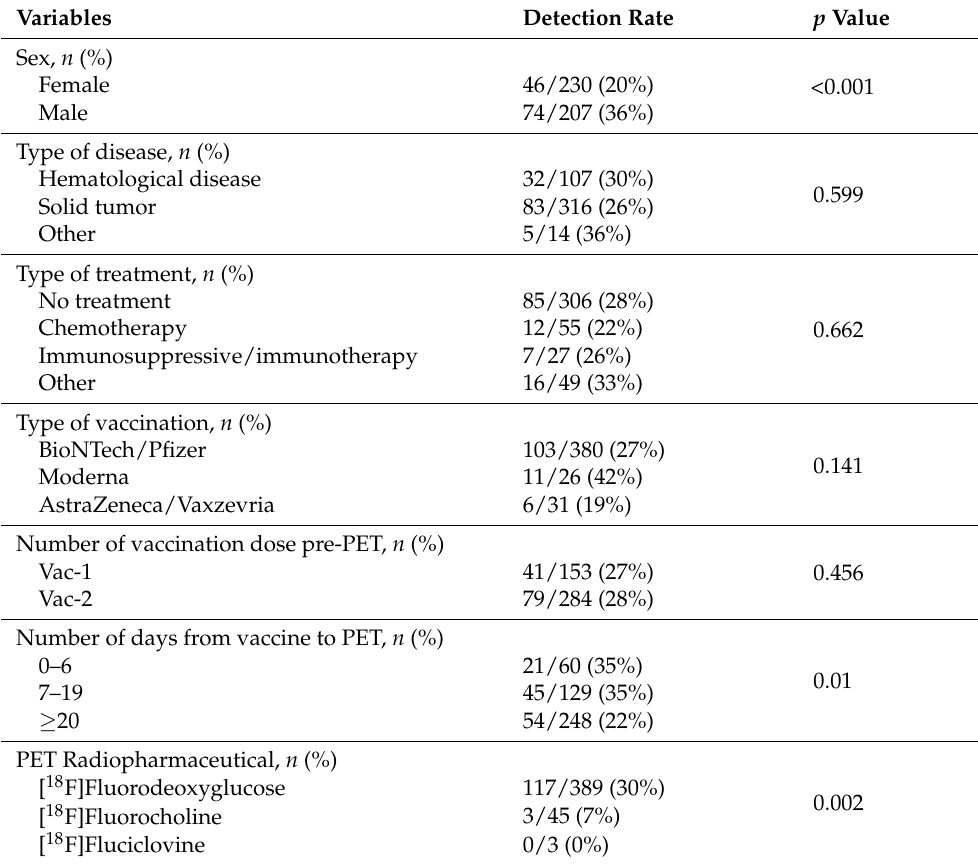
Table 3. Correlation between HLN detection rate and categorical variables in Vac-group.